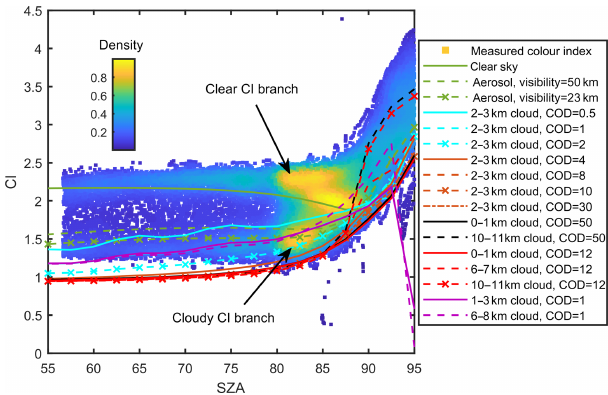
Figure 1. Colour index as a function of solar zenith angle. The measurements are from the UT-GBS in 2011, colour-coded by the normalized density of the points. Colour lines are examples of radiative transfer model CI simulations, using a surface albedo of 0.06 and the MPIC climatology ozone profile (total column ozone = 425DU), and twelve sub-layers within each cloud layer. Cloud height and cloud optical density (COD) are indicated in the